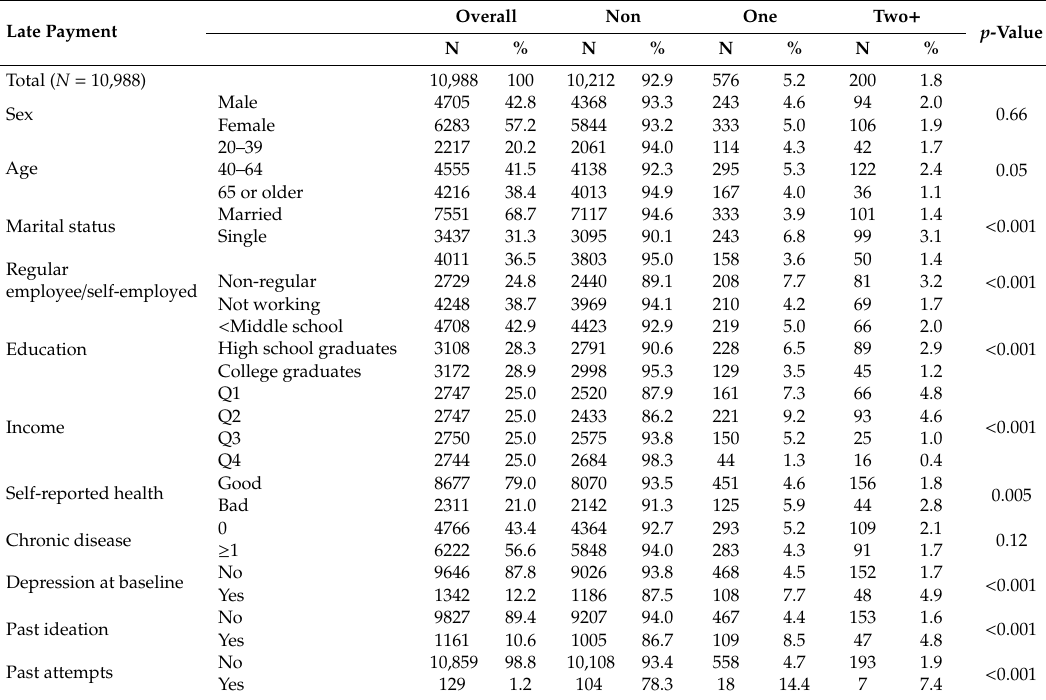
Table 1. General characteristics of study population.